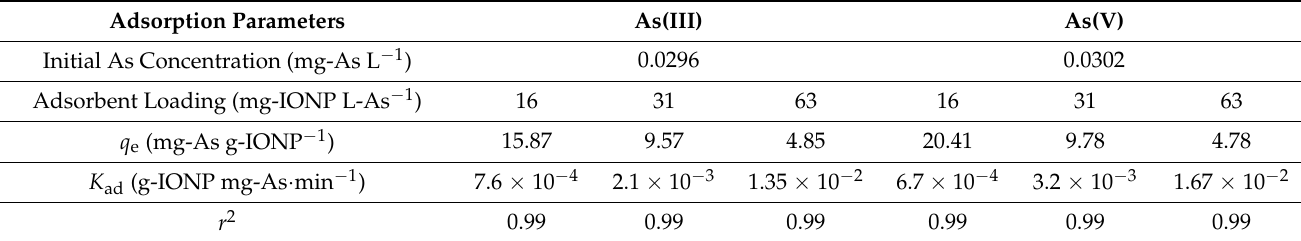
Figure 1. As(III) and As(V) adsorption kinetics with three different IONP loadings within CNF aer- ogel. The reported dosages are the IONP concentrations. The fitted aqueous arsenic concentrations were determined from the difference between the initial and adsorbed arsenic concentrations. The inset graphs are the pseudo second-order kinetic fits for the corresponding dosage of adsorbent according to Equation (6). Table 1. Summary of kinetic parameters for As(III) and As(V) adsorption on IONPs in CNF-IONP aerogel. Adsorption Parameters